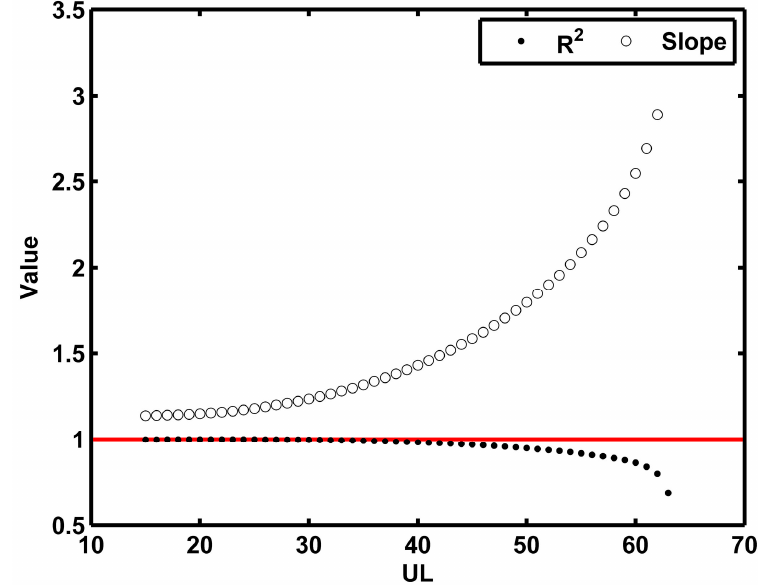
Figure 2. Change curves of the R 2 and the coefficient slope of regressions when pixels with DN ≤ UL are added into the regression gradually: The R 2 decreases sharply when UL > 50, and the coefficient slope gets further away from 1 when UL > 50.